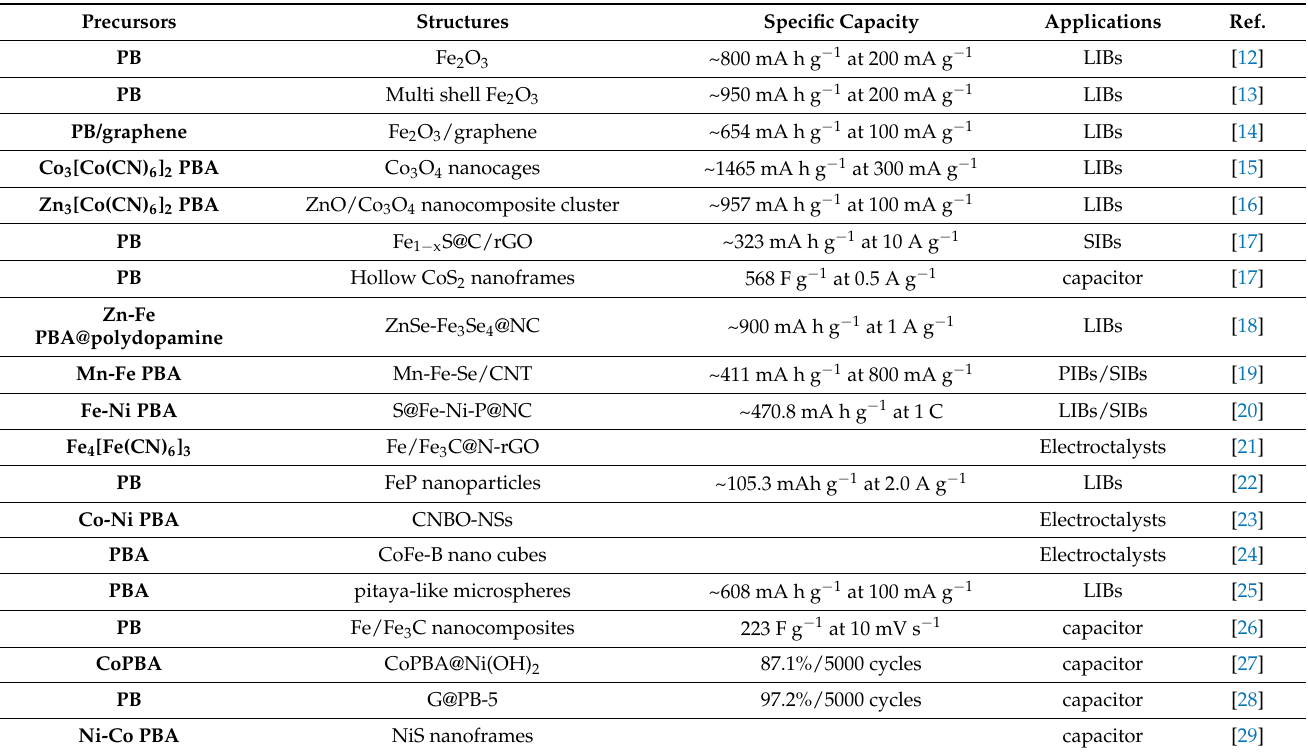
Table 1. The electrochemical performance of PB and its derivatives for energy